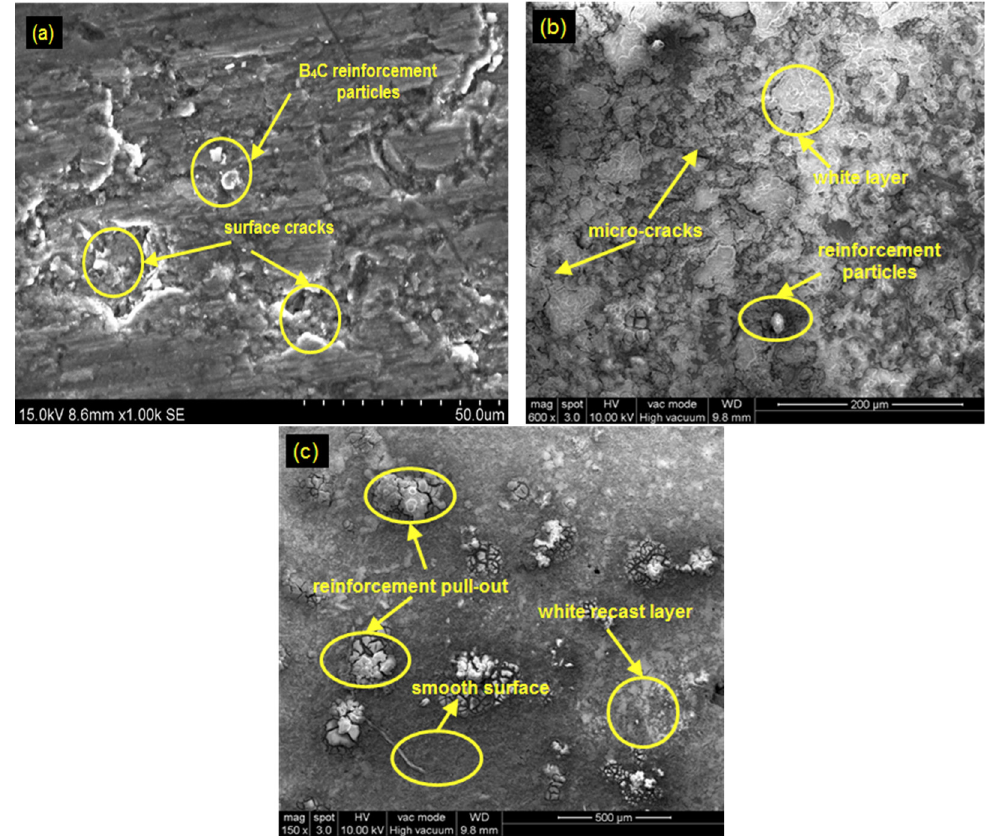
Figure 10. SEM micrograph of WEDM machined composite surface at a cutting condition of ( a ) 70 V gap voltage and 9 wt% of B 4 C reinforcement; ( b ) 30 V gap voltage and 10 µs pulse-on time; ( c ) 29.89 V gap voltage, 9.79 µs pulse-on time, 1.97 µs pulse-off time, 3.98 m/min wire feed, and 3.03 wt% of B 4 C reinforcement.